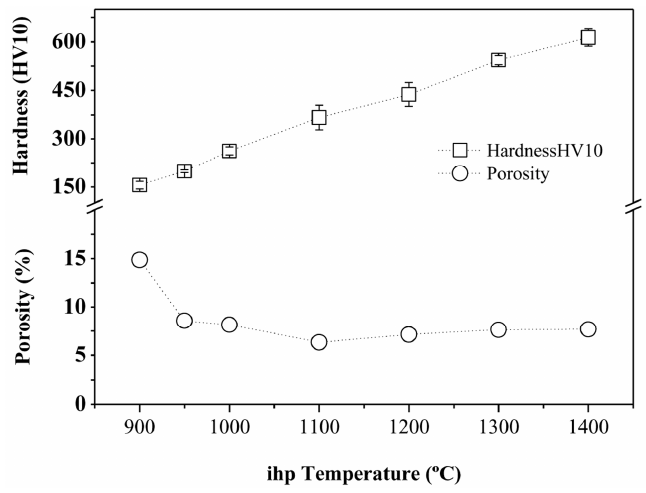
Figure 8. Hardness (HV10) and porosity (%) vs. iHP temperature (°C).